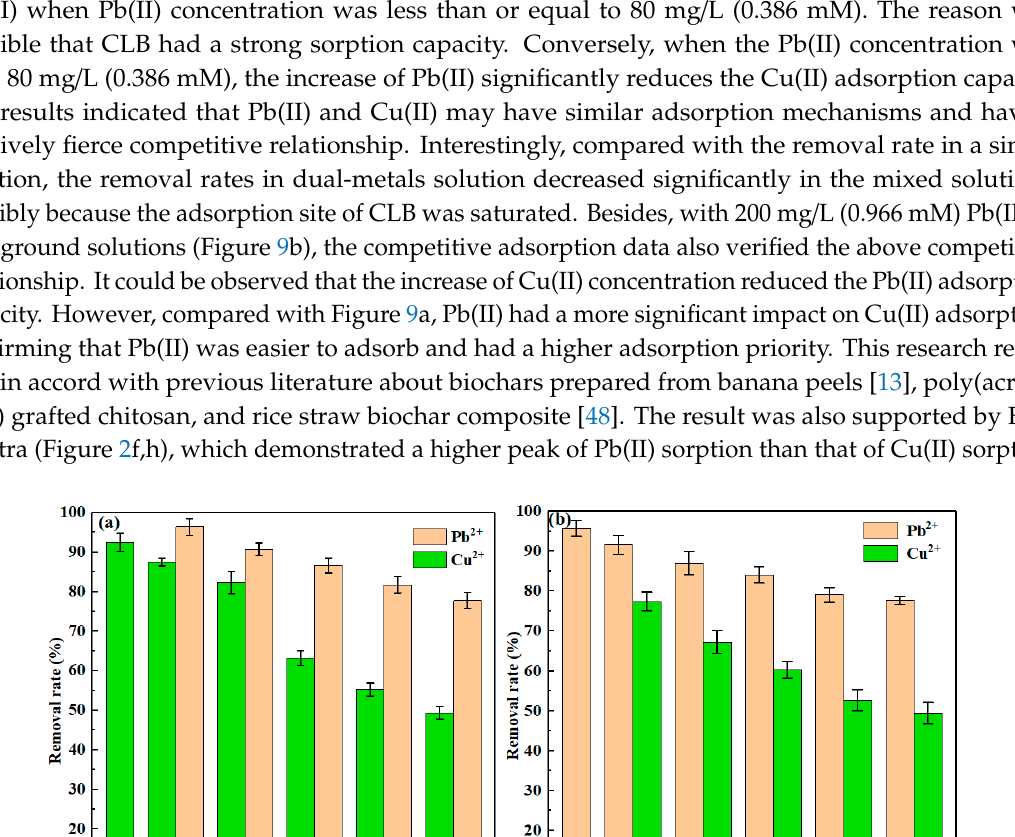
Figure 8. Effect of pH value on 200 mg/L Cu(II) ( a ) and 200 mg/L Pb(II) ( b ) sorption onto CLB, respectively. (adsorbent dose: 0.5 g; solution volume: 200 mL; temperature: 25 ± 1 °C; contact time: 24 h).